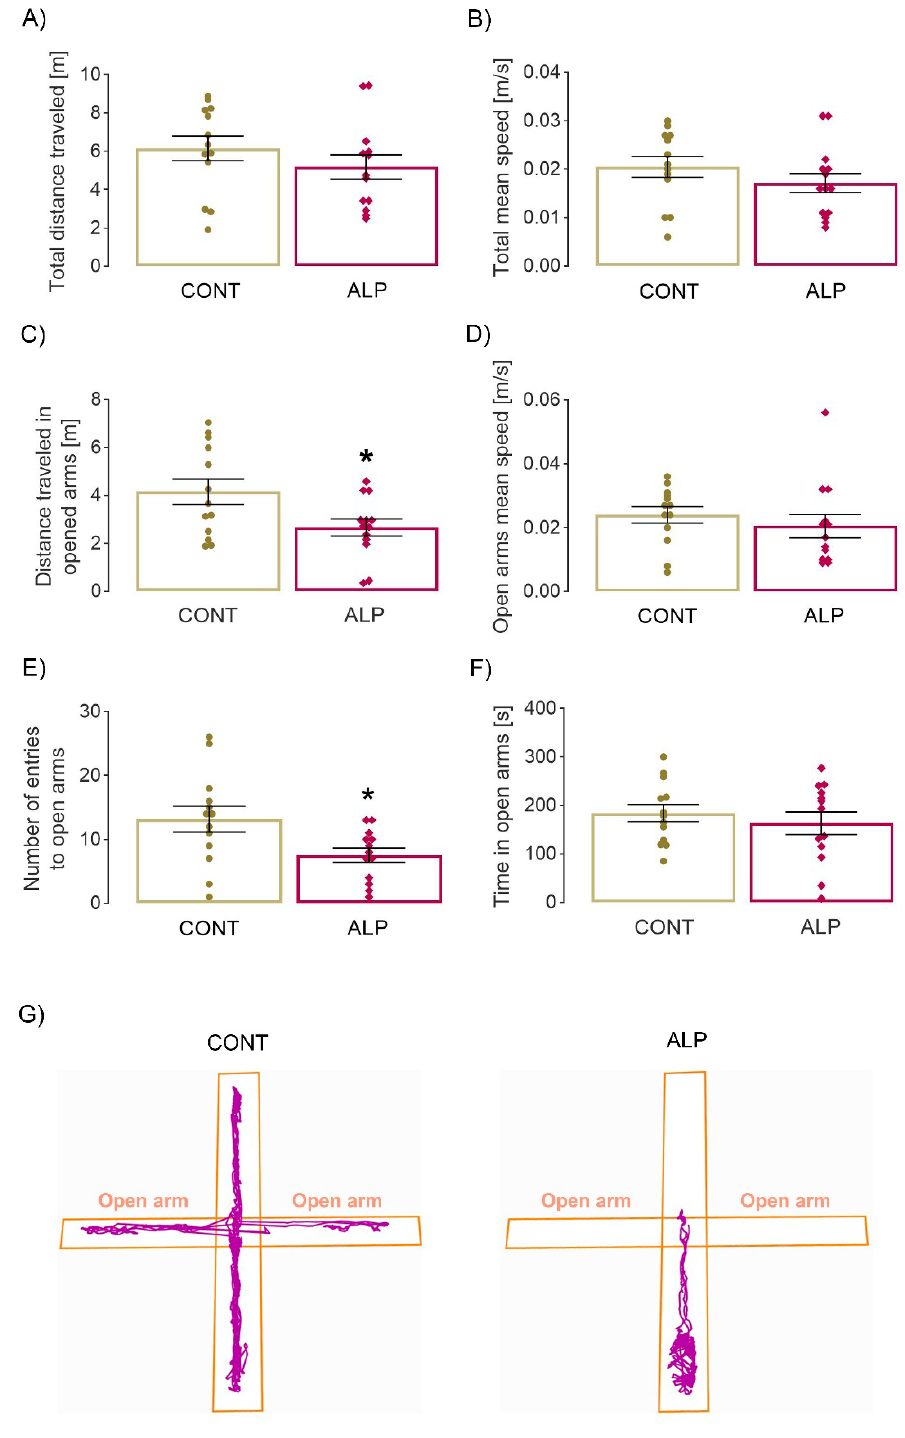
Figure 2. Effect of prolonged 14 days ALP treatment on behavioral parameters in elevated plus maze test. ( A ) Total distance traveled in maze [m], ( B ) total mean speed [m/s], ( C ) distance traveled in open arms [m], ( D ) mean speed in open arms [m/s], ( E ) number of entries to open arms, ( F ) time spent in open arms [s], ( G ) representative track plots of VEH (left) and ALP (right) group. Data were statistically analyzed by two-tailed t -test and expressed as percentage of the mean values of CONT group ± SEM (dots in the graphs represent values of individual animals). Symbols indicate significant differences between CONT and ALP group: * p < 0.05; animals per group: 13.